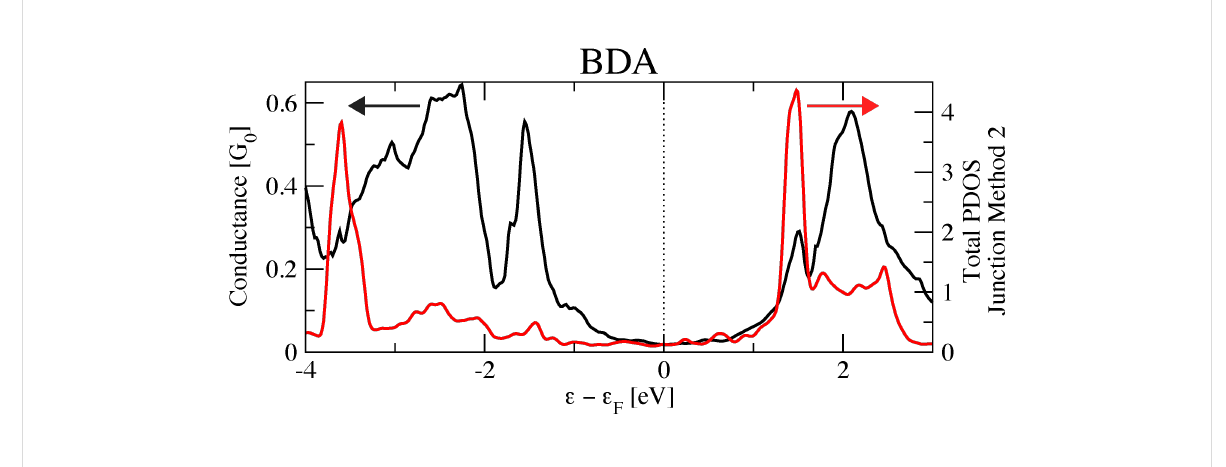
Figure 3: Total molecular PDOS (red line) and conductance (black line) of BDA. The total molecular PDOS is the sum of the PDOS onto the MOs from HOMO − 2 to LUMO+2 as obtained from Method 2.